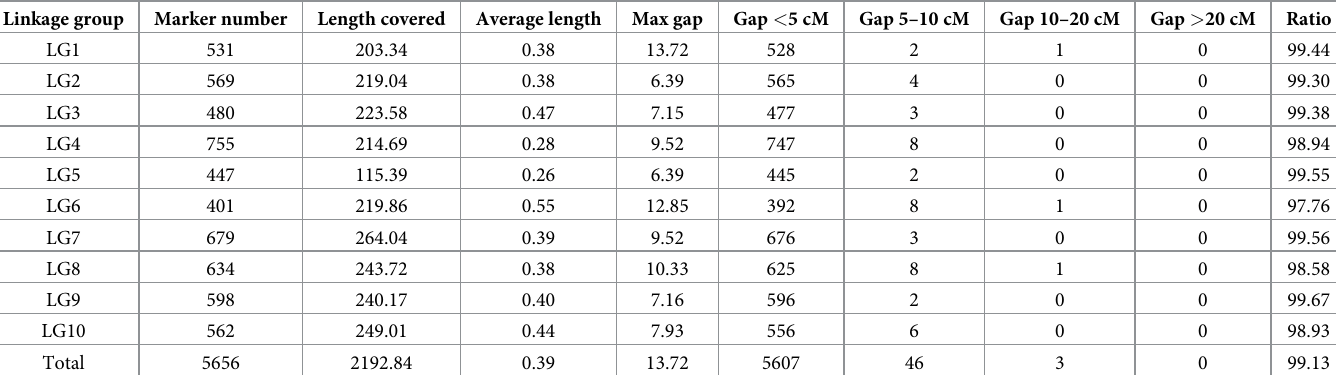
Table 4. Characteristics of genetic linkage groups of sorghum-sudangrass hybrid. Linkage group Marker number